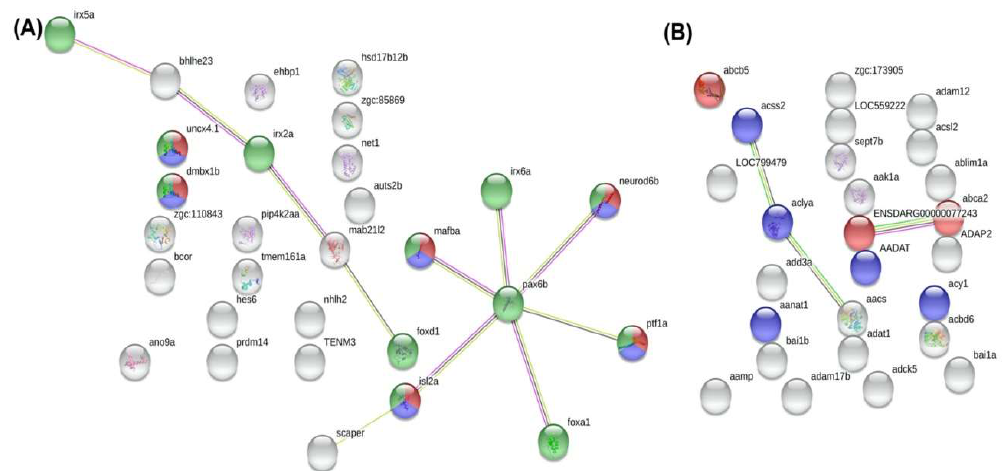
Figure 11. STRING protein interaction networking analysis between the ( A ) WT and dnmt3aa , and ( B ) WT and dnmt3ab KO zebrafish gene sets. ( A ) Red node represented protein involving in neuronal development; blue node represented DNA binding proteins; green node represented nucleic proteins. ( B ) Red node represented ABC transporter-related proteins; blue node represented proteins that associated metabolic pathways.